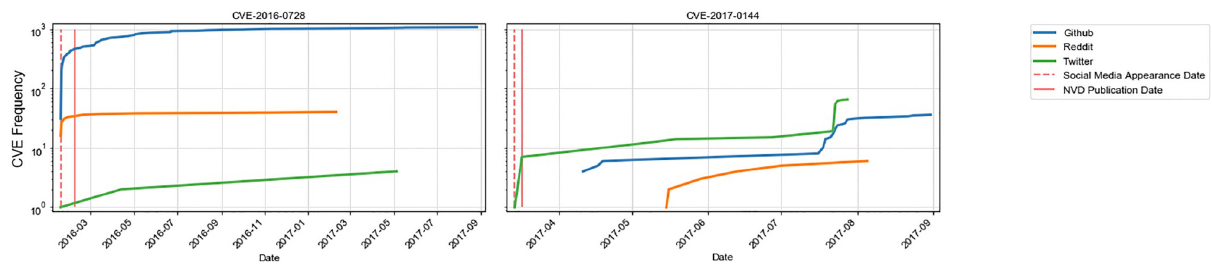
Fig 1. Example CVEs that appear on social media before published in